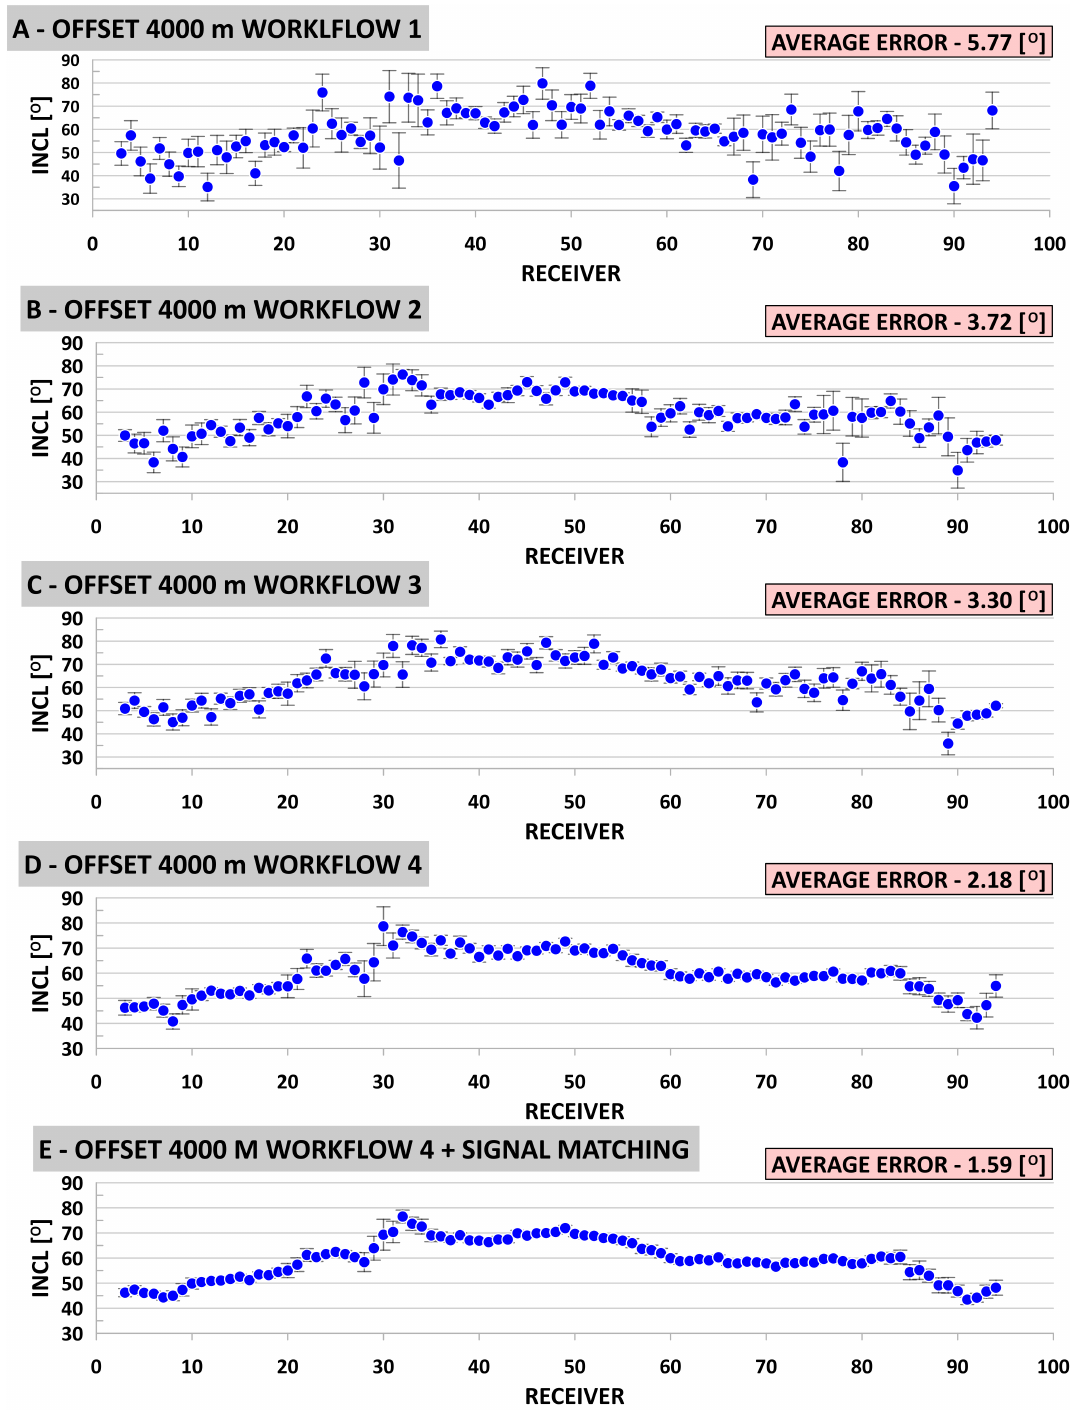
Figure 9. P-wave polarization angles ( dots ) with error bars for different workflow schemes for the far offset shot point (4000 m): A is for W1, B for W2, C for W3, D for W4, and E is for W4 with signal-matching procedure